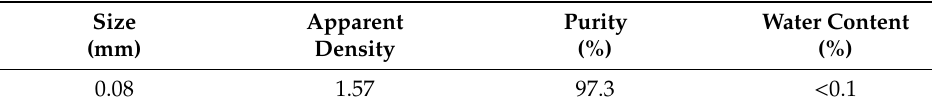
Table 3. Properties of silica sand.